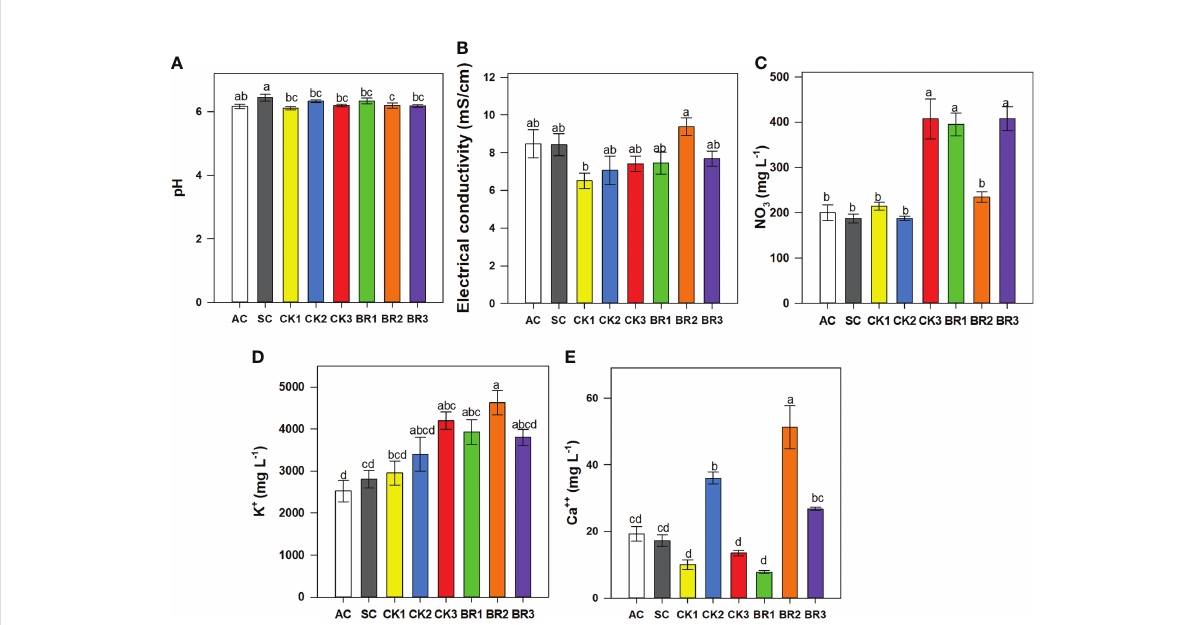
FIGURE 3 Effect of the number of applications of two growth regulators (cytokinins (CK) or brassinosteroids (BR)) on pH (A) , electrical conductivity (B) , and contents of nitrate (C) , potassium (D) , and calcium (E) in rice plants of genotype Fedearroz 2000 subjected to combined heat stress (40°C day/ 30°C night) at 55 days after emergence (DAE). The treatments evaluated were as follows: absolute control (AC), heat stress control (SC), one foliar spray of CK (CK1), two foliar sprays of CK (CK2), three foliar sprays of CK (CK3), one foliar spray of BR (BR1), two foliar sprays of BR (BR2) or three foliar sprays of BR (BR3). Each column represents the mean of fi ve data ± standard error (n = 5). Bars followed by different letters indicate statistically signi fi cant differences according to Tukey ’ s test (P ≤ 0.05). Equal letters indicate that the means are not statistically signi fi cant ( ≤ 0.05).